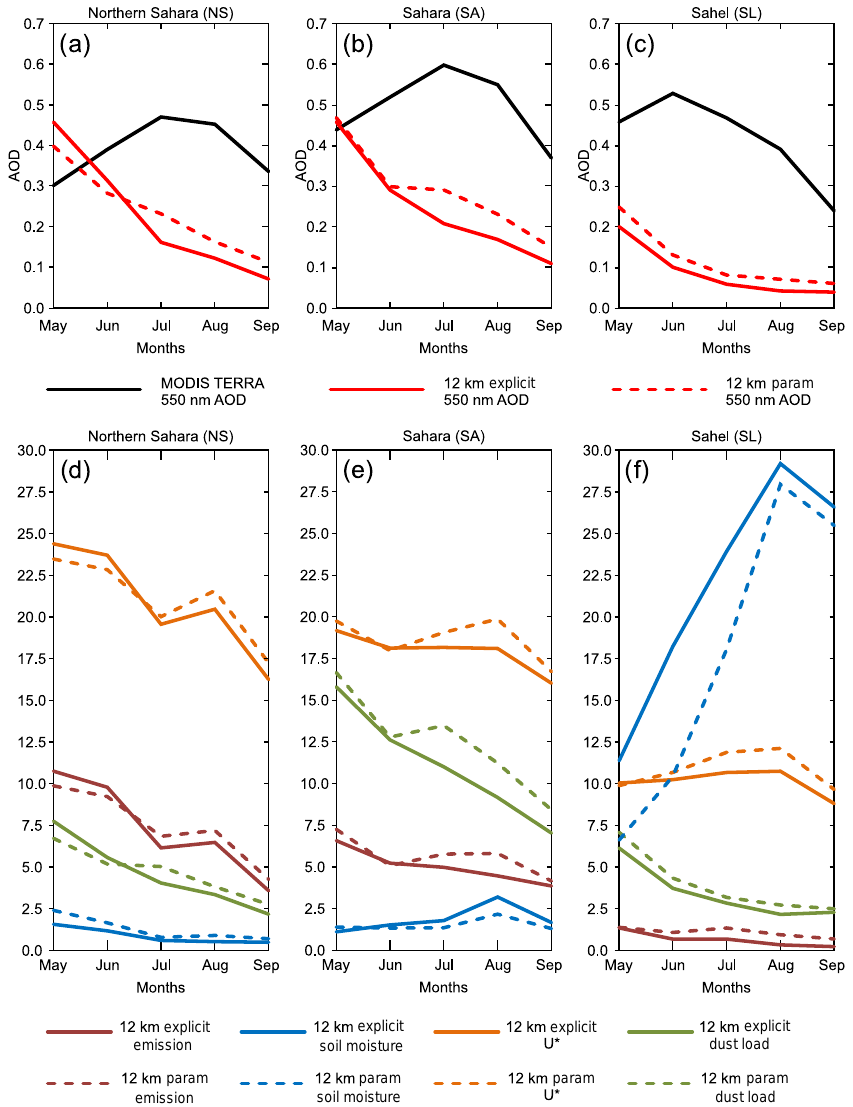
Figure 6. Monthly mean (May–September) aerosol optical depths averaged over (a) the northern Sahara (NS) region, (b) the Sahara region (SA) and (c) the Sahel region (SL). Shown are 12km explicit simulation (12E), 12km parameterised simulation (12P) and MODIS (Terra). Also shown are (d) NS, (e) SA and (f) SL dust emissions (µgm − 2 s − 1 ), total regional dust load (Tg), friction velocity ( U ∗ ; cms − 1 ) and soil moisture in the top 10cm layer (kgm − 2 ). For ease of visibility on the plot, dust loads for NS and SA are scaled by a factor of 5 and for SL dust loads and dust emissions are scaled by a factor of